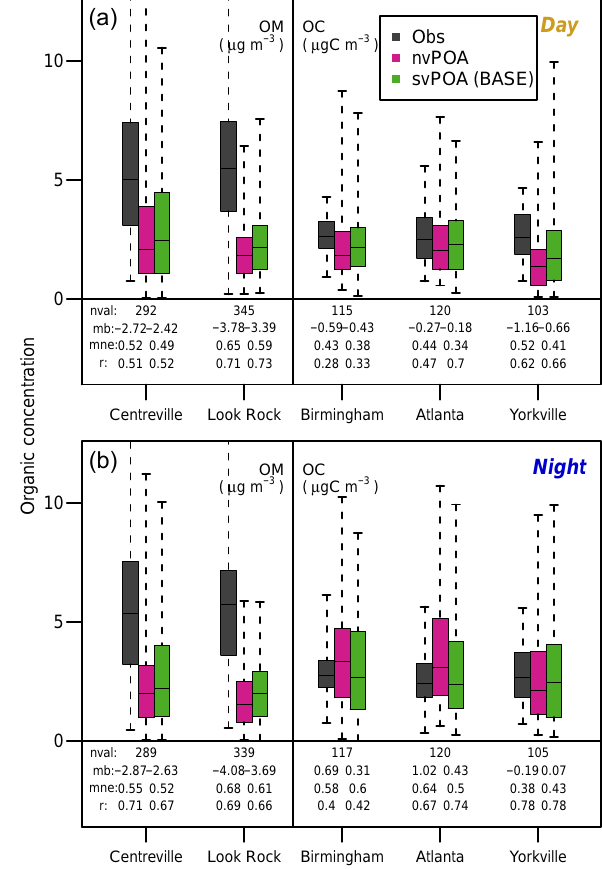
Figure 1. Organic aerosol concentrations (µgm − 3 ) observed (gray) with the HR-ToF-AMS at sites in California in 2010 (Pasadena, Bakersfield, Sacramento, and Cool). Also shown are the model- predicted distributions at each site using the nonvolatile (pink) and base-case semivolatile (green) configurations. The boxes denote the 25th and 75th percentiles of each dataset, while the whiskers ex- tend to the most extreme points. (a) and (b) show data for daytime (08:00–20:00LT) and nighttime hours, respectively. Model values are projected to PM 1 to correspond roughly to the size cutoff of the AMS.